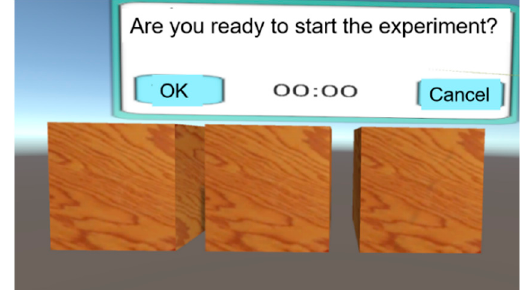
Figure 16. Example of displayed cubes.